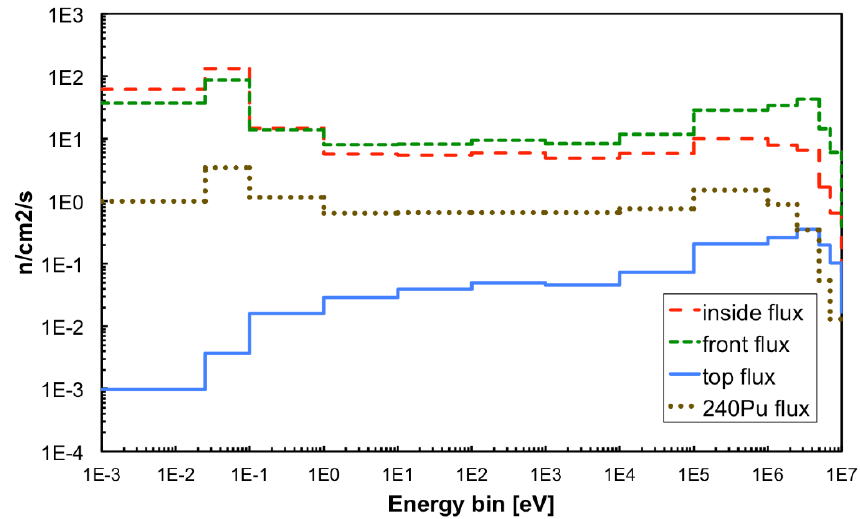
Figure 8. ( a ) Drawing of the 3D side view of the neutron source box, the red box indicates the top position; ( b ) the corresponding neutron flux obtained by means of a simulation with the Fluka code.